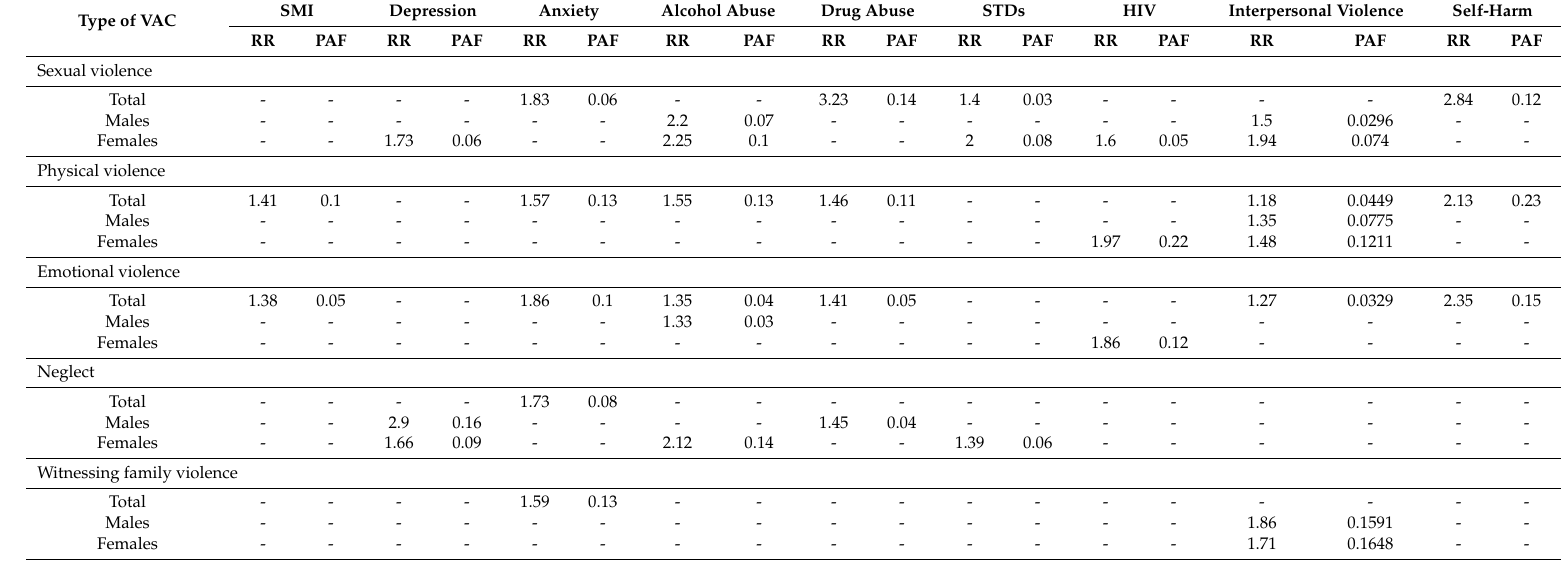
Table 3. Population attributable fractions (PAFs) and relative risks (RRs) for health outcomes associated with violence against children. Type of